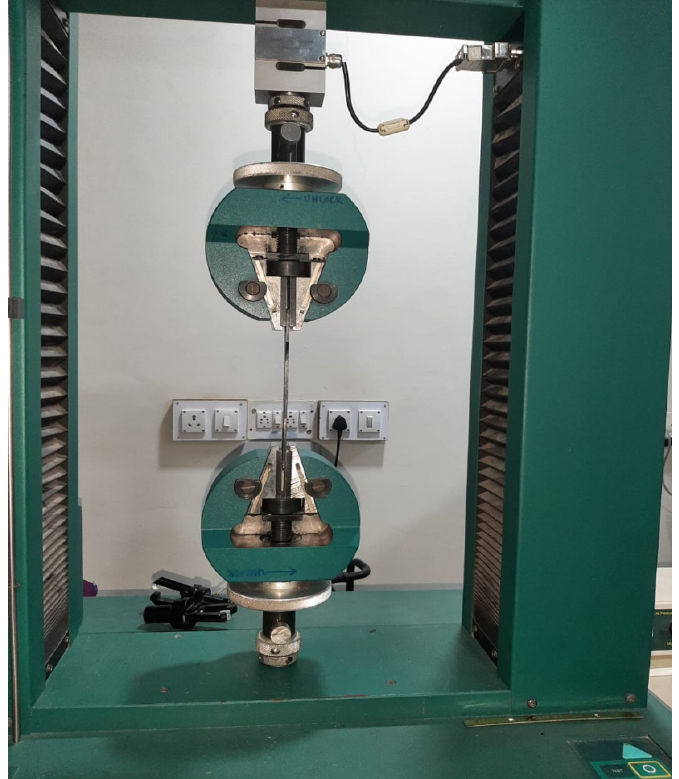
Figure 3. Universal Testing Machine.